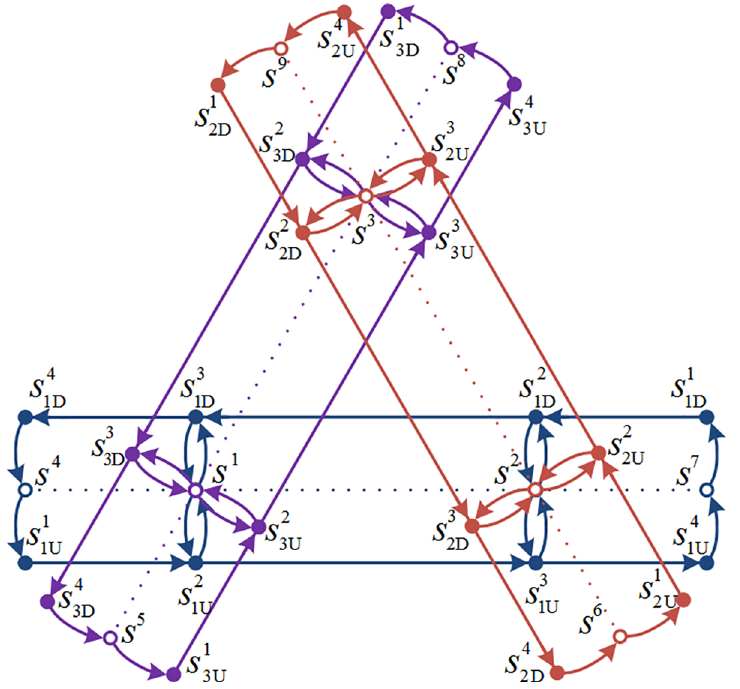
Fig 2. Illustration of the urban rail network with three